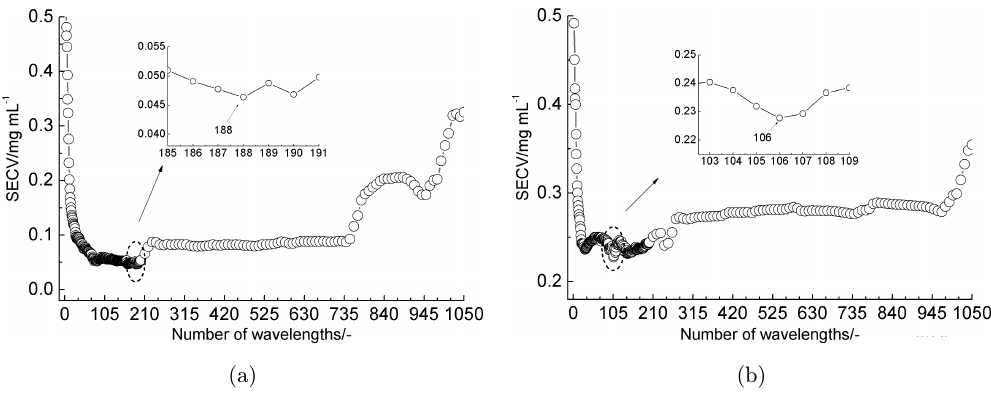
Fig. 9. Optimal SECV corresponding to the number of wavelengths for (a) TCP and (b)